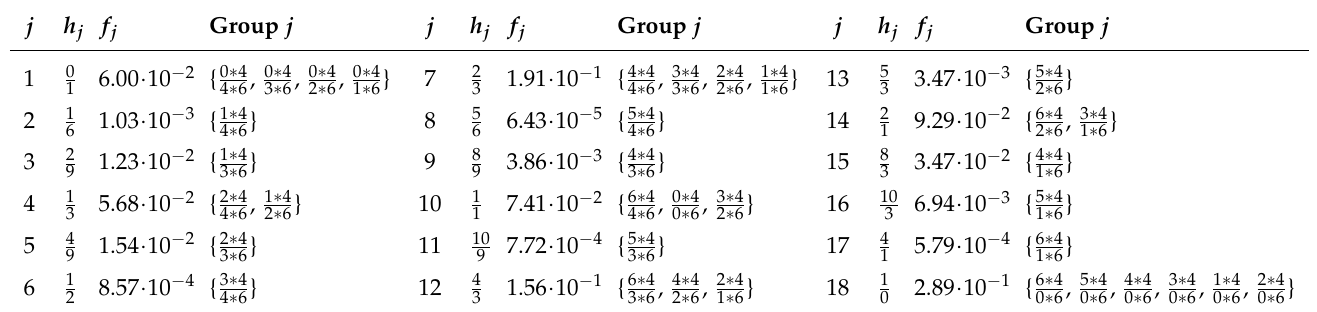
Table A6. Sorted and grouped relative risks ( h j ) and their associated probabilities ( f j ) for the data in Table A3. j